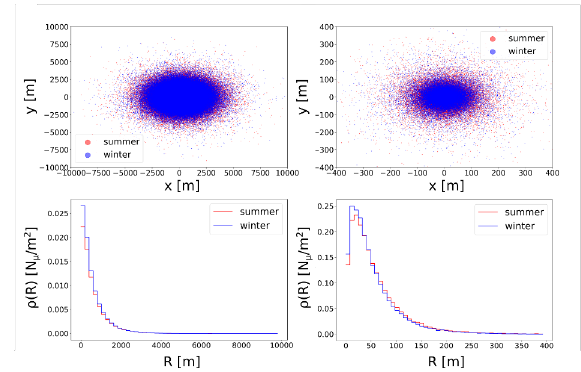
Table 4: Number of multi-muons events as a function of energy for summer ( n S ) and winter ( n W ), their ratio ( n S / n W ) and percentage di ff erence ( D SW ) between sum- mer and winter multi-muon events for θ = 30 ◦ .